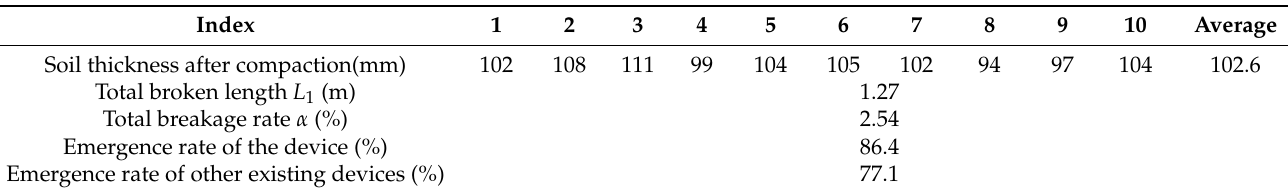
Figure 12. The comprehensive test in the field. Figure 13. ( a ) Cane seed planted by this device. ( b ) Cane seed planted by other existing devices.